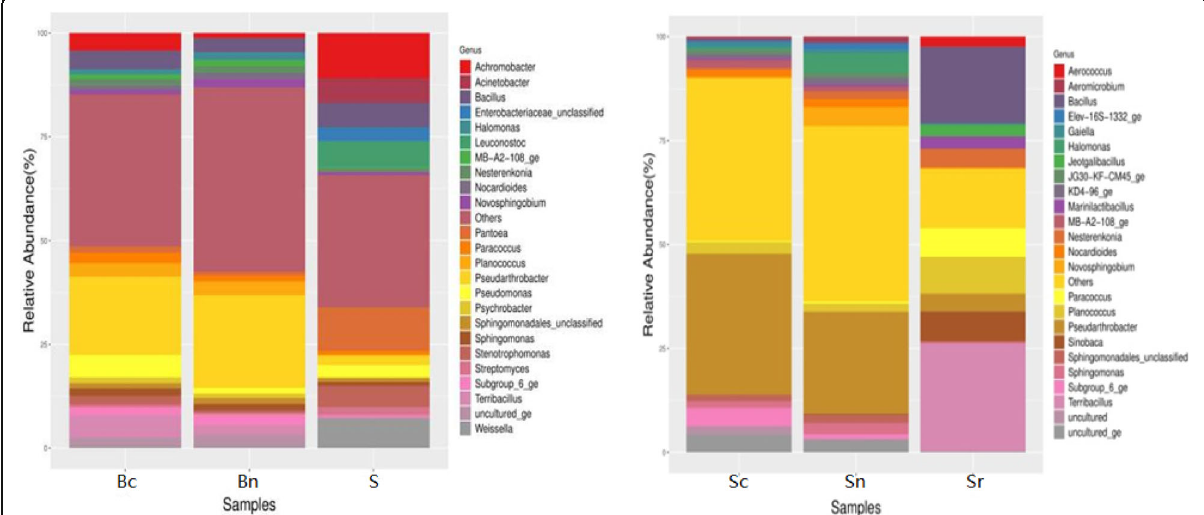
Fig. 5 Relative abundance of shared/unshared genera in each sample. The top 24 genera of each sample were selected, and the less abundant taxa were grouped in “ others ”